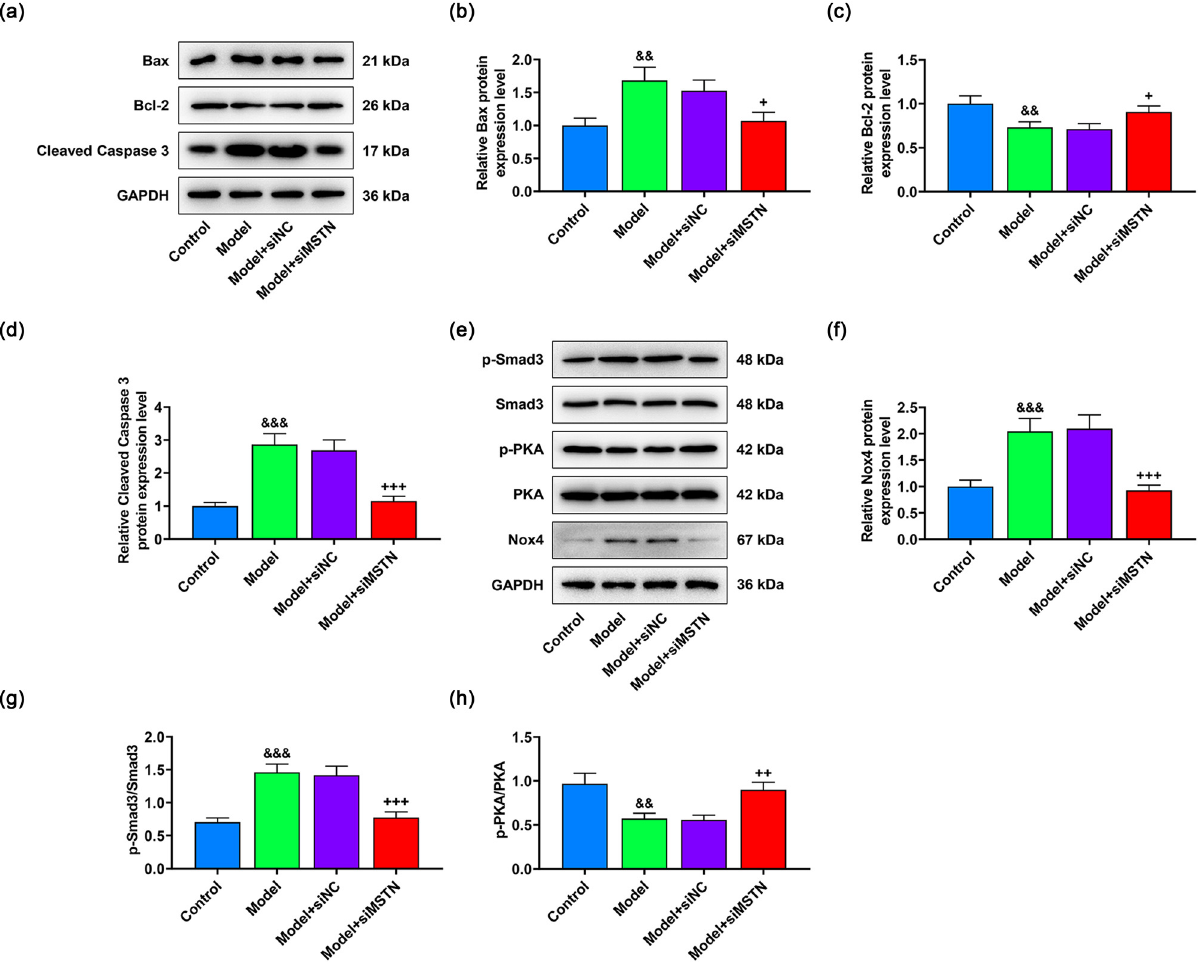
Figure 4: E ff ects of siMTSN on the protein expressions related to apoptosis and Smad3/PKA/Nox4 signaling pathway in Ang II - induced AB8/ 13 cells. AB8/13 cells were treated with Ang II ( 100 nmol/L ) to induce MN cell model, followed by the transfection of siNC or siMSTN. ( a – d ) Expressions of apoptosis - related proteins ( Bax, Bcl - 2, and cleaved Caspase - 3 ) in the control, model, model + siNC, and model +